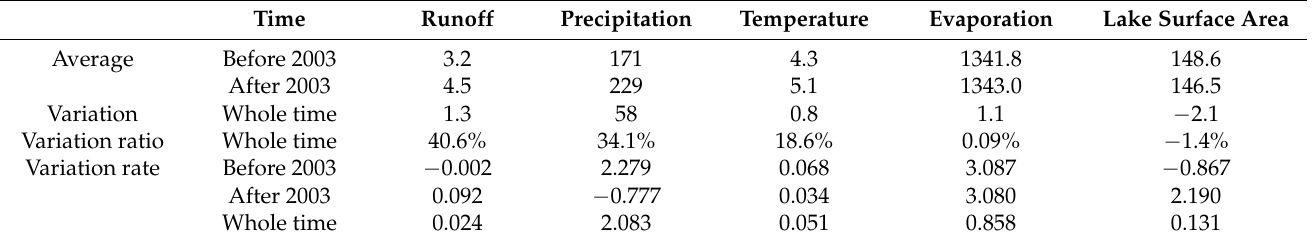
Table 3. Variation of factors affecting the Tuosu Lake surface area before 2003 and after